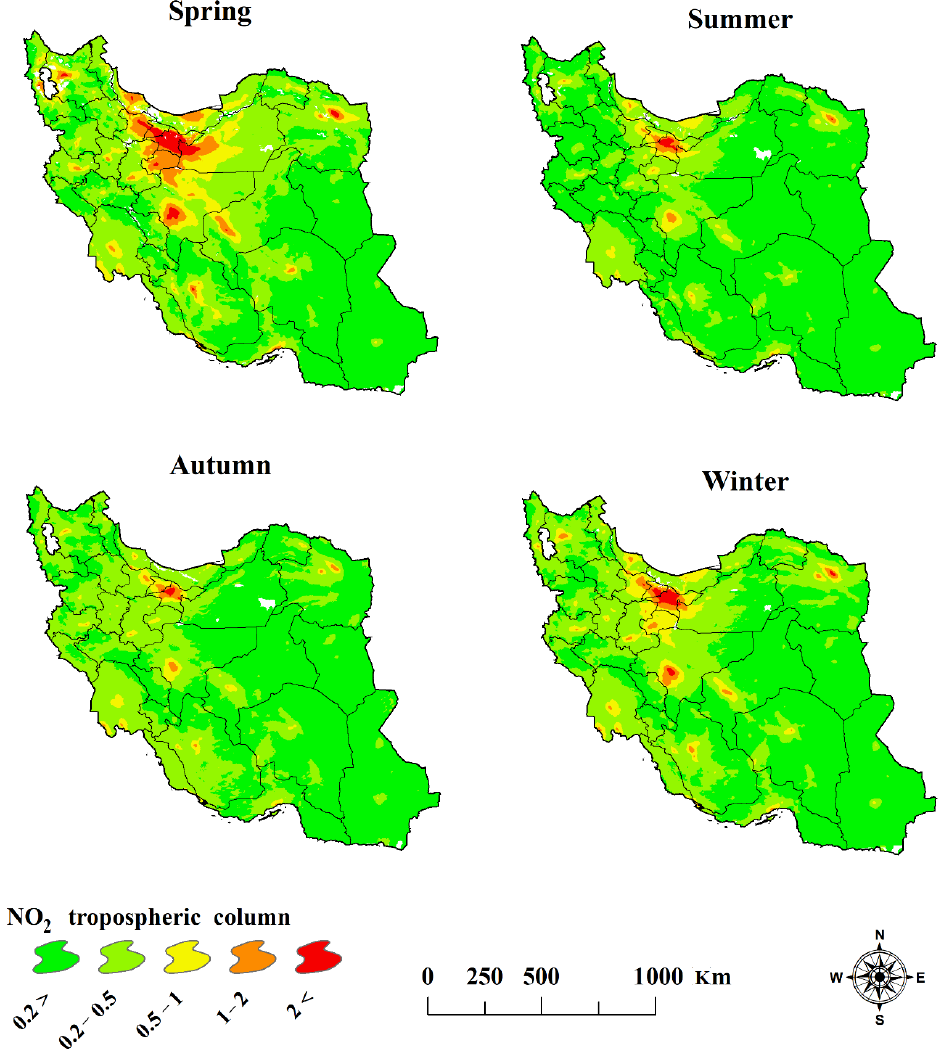
Figure 6. Seasonal tropospheric NO 2 column concentration (10 15 molecules cm −2 ) in Iran (2018 – 2021), Spring (March, April, and May); Summer (June, July, and August); Autumn (September, October, and November); Winter (December, January, and February). Table 3. Statistical values of NO 2 using S5P in 2018 – 2021.